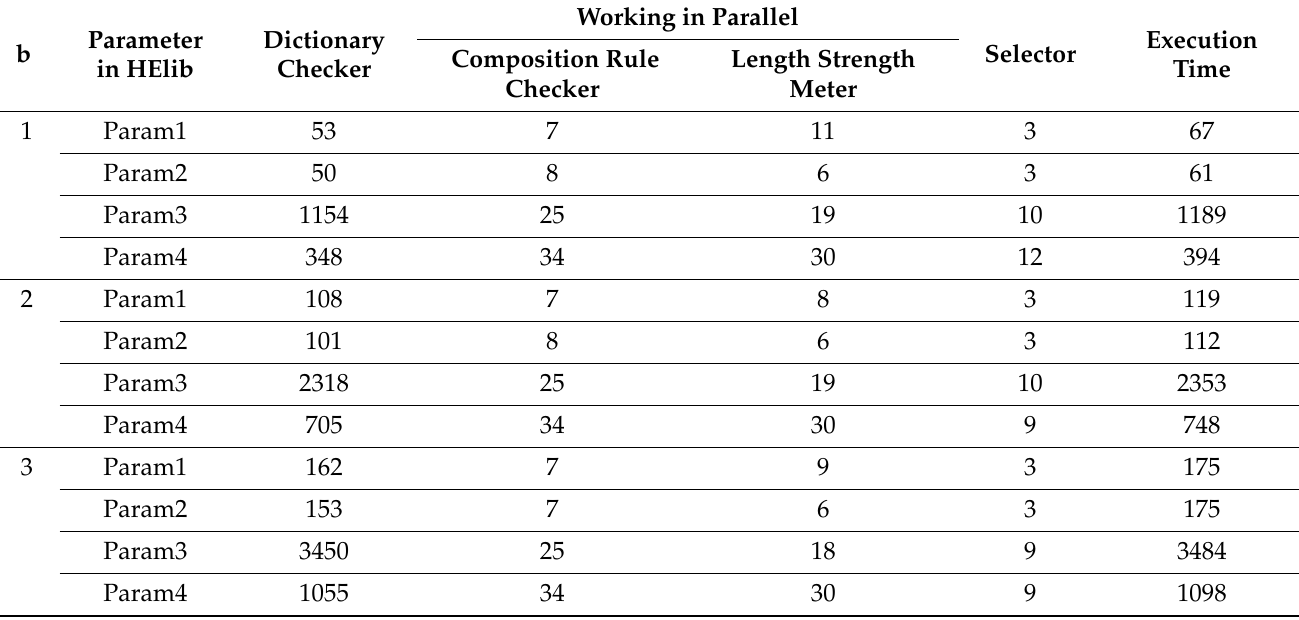
Table 6. Total execution time (in s).